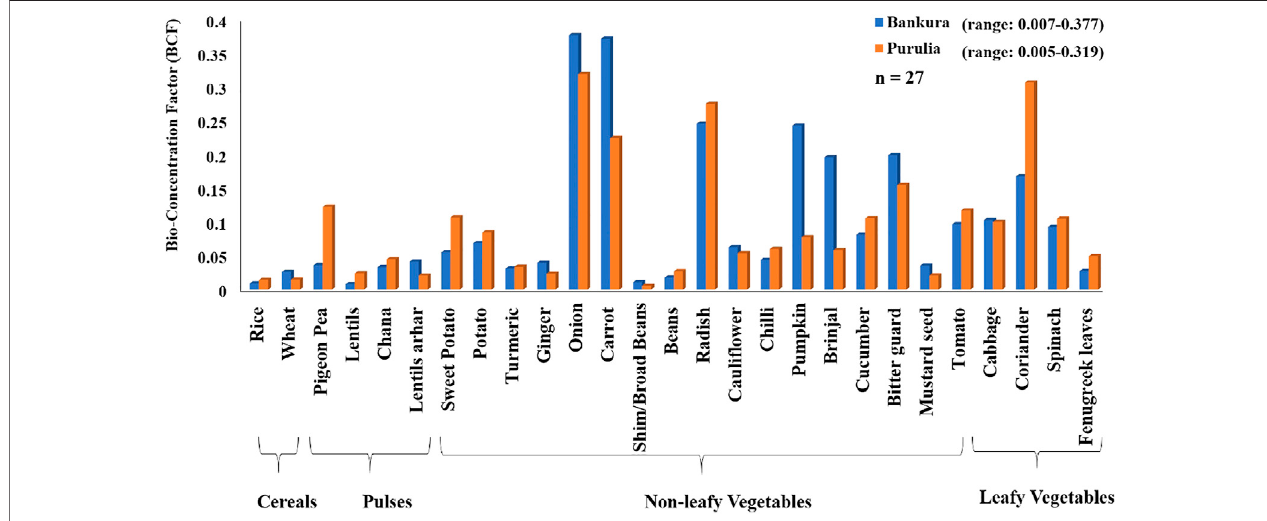
FIGURE 3 | Average bioconcentration factor (BCF) of fl uoride on cereals, pulses, and nonleafy and leafy vegetable items at Bankura and Purulia districts.